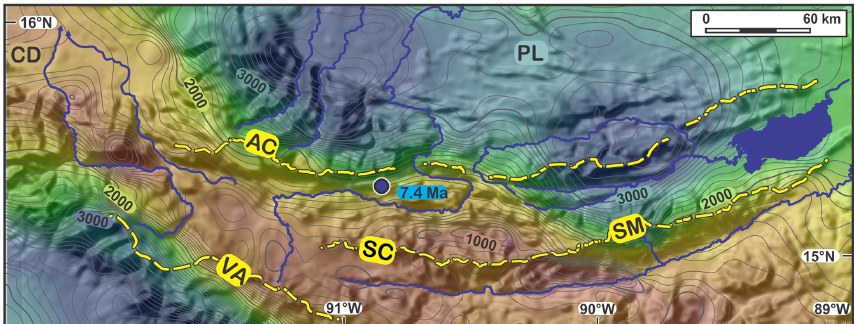
Figure 4. Mean annual precipitation across the study (MARN, 2016) from dry (red) to wet (blue). Isohyet spacing is 100mm, draped over the shadowed GTOPO 30 DEM. Dashed yellow lines show the range drainage divides. The blue dot shows the location of the fossil forest of Sicaché, buried below a 7.4Myr ignimbrite (Brocard et al., 2011). CD stands for Central Depression of Chiapas, AC stands for Altos de Cuchumatanes, PL stands for Petén lowlands, SC stands for Sierra de Chuacús, SM stands for Sierra de las Minas, and VA stands for volcanic